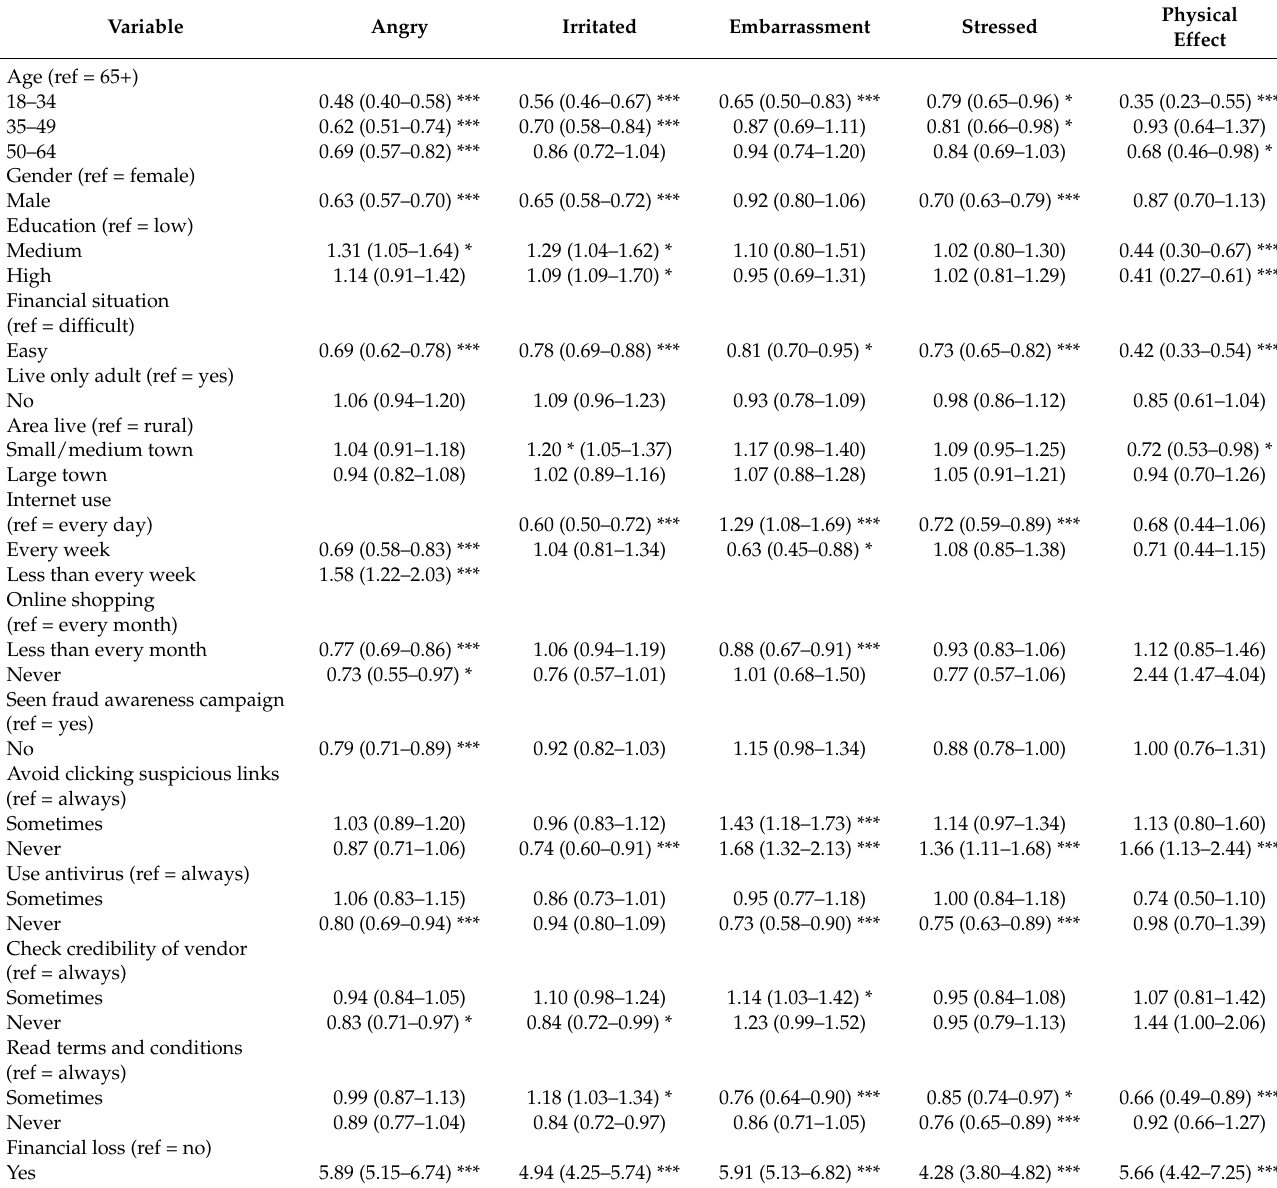
Table 12. Odds ratios and 95% CI for non-financial effects of online fraud ( n =